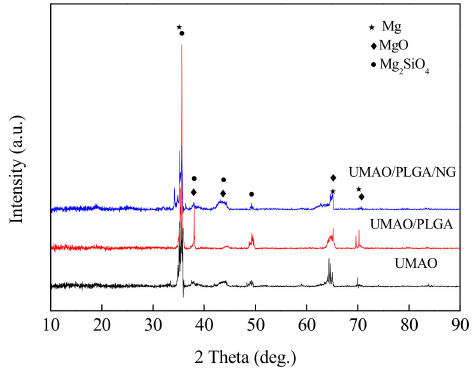
Figure 1. X-ray diffraction (XRD) of different